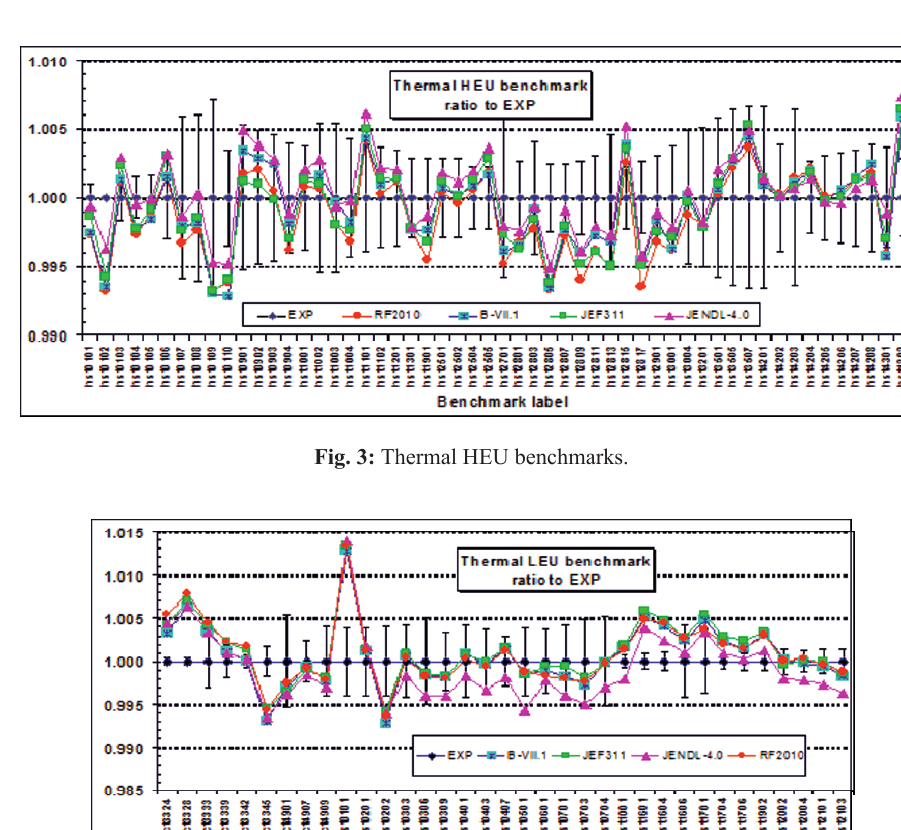
Fig. 2: Na and Pb benchmarks.